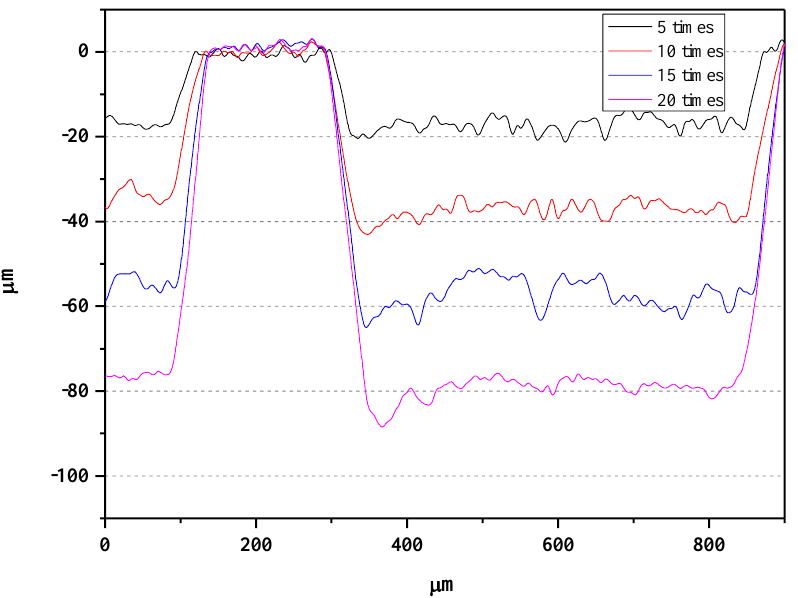
Figure 8. The surface profile according to the number of repeated cycles in the DEE (etching voltage: 10 V, etching time: 7 s).